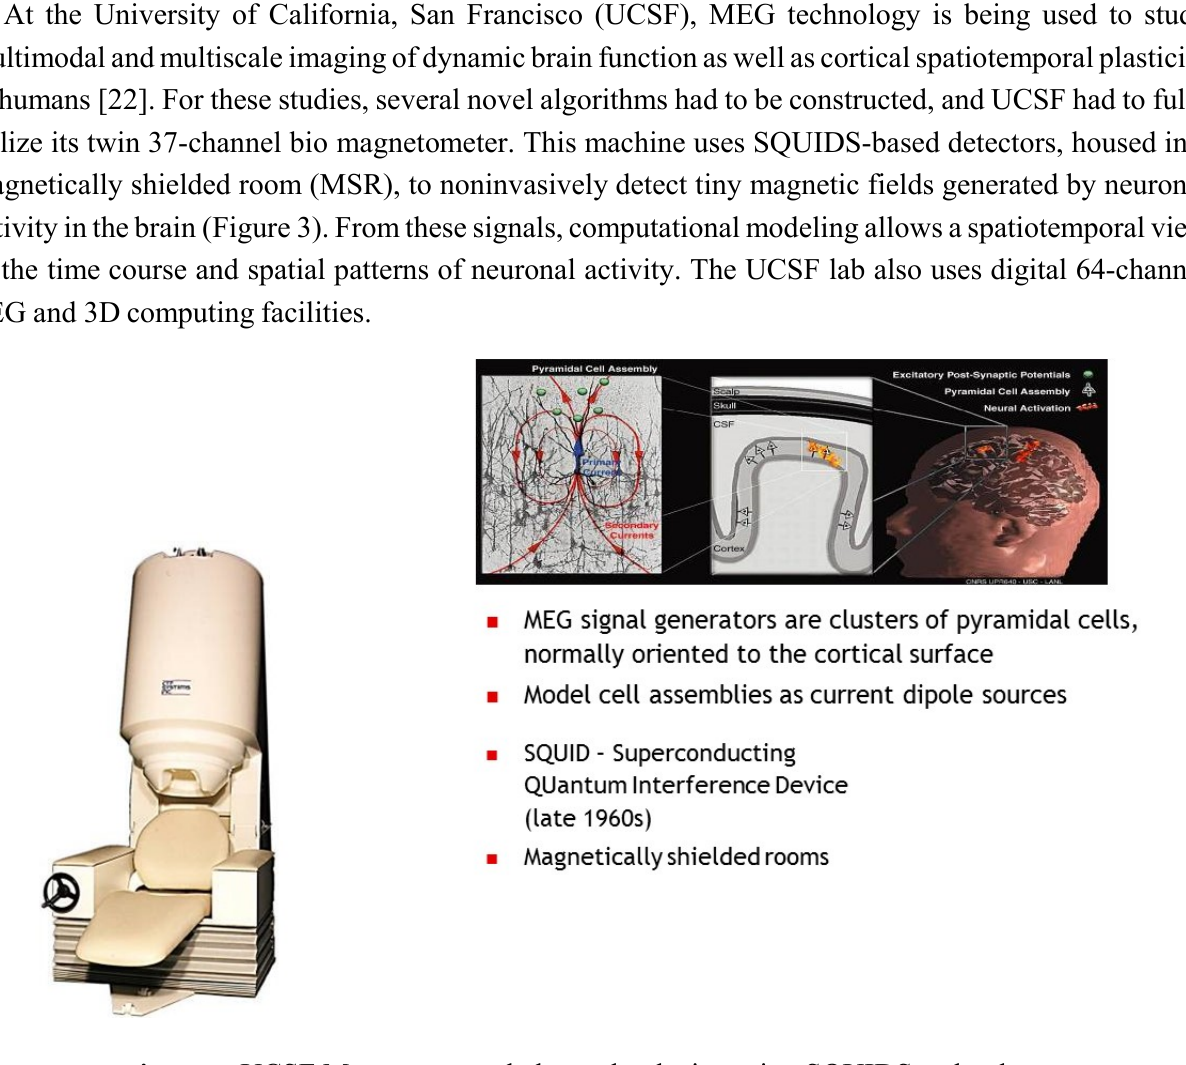
Figure 3. UCSF Magneto encephalography device using SQUIDS